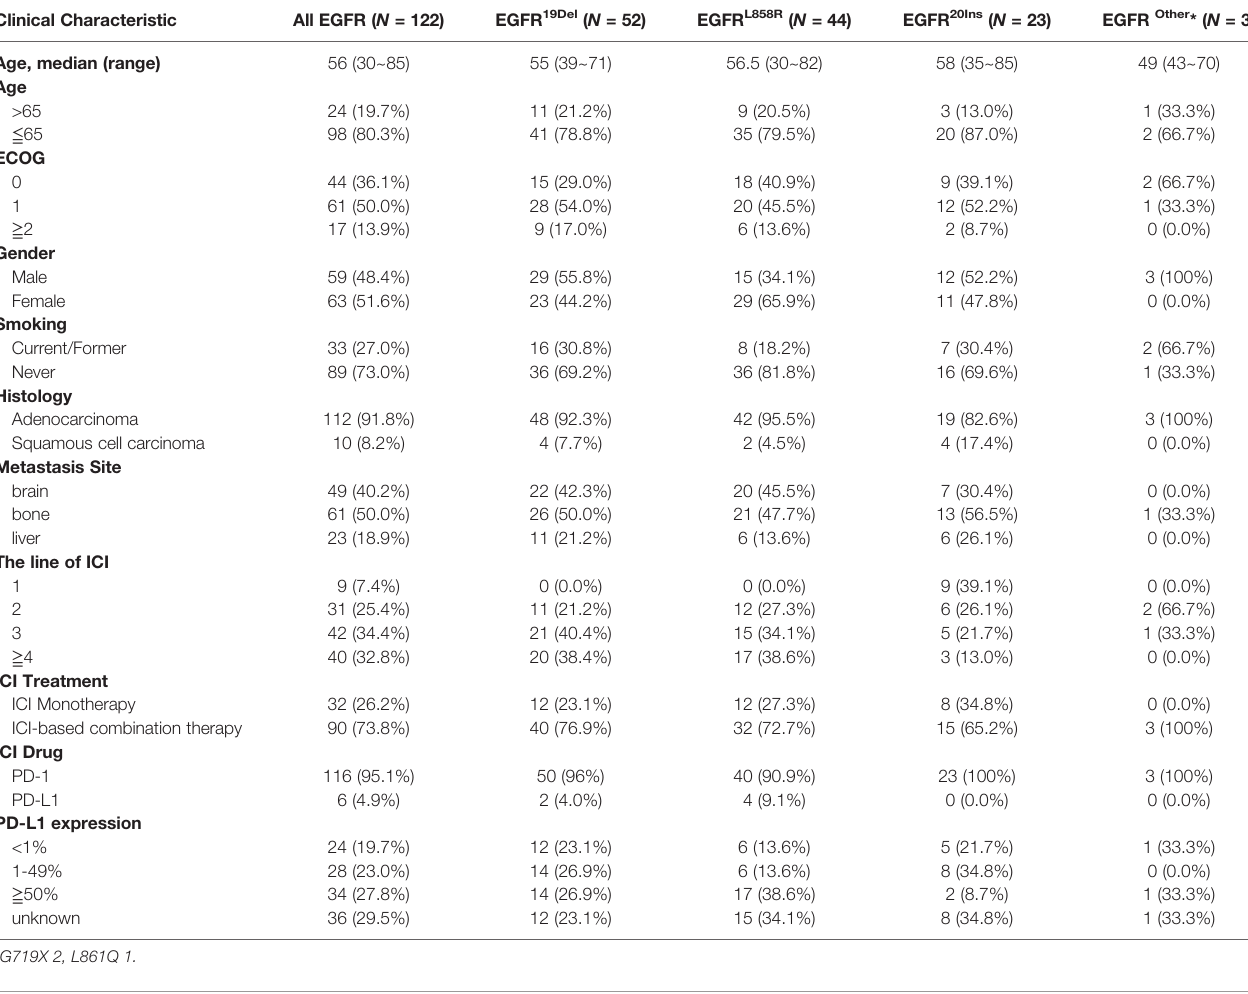
TABLE 1 | Characteristics of NSCLC patients with EGFR mutation treated with the immune checkpoint inhibitors. Clinical Characteristic